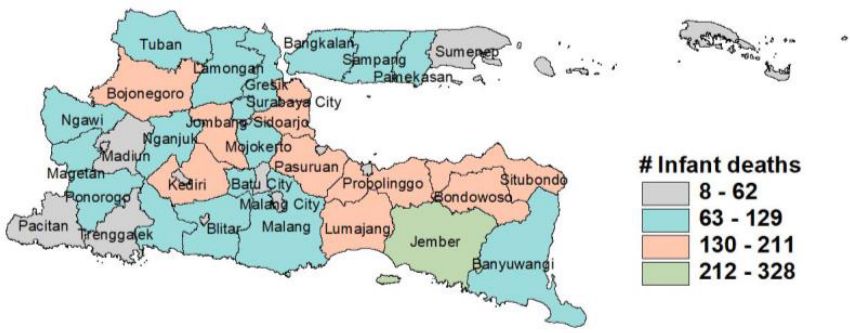
Figure 1. Distribution of the number of infant deaths in East Java in 2019.